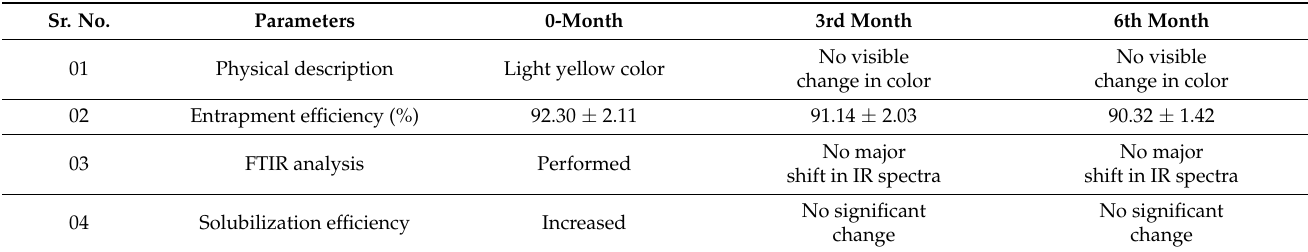
Table 1. Stability studies of simvastatin-loaded cross-linked nanomatrices. Sr.